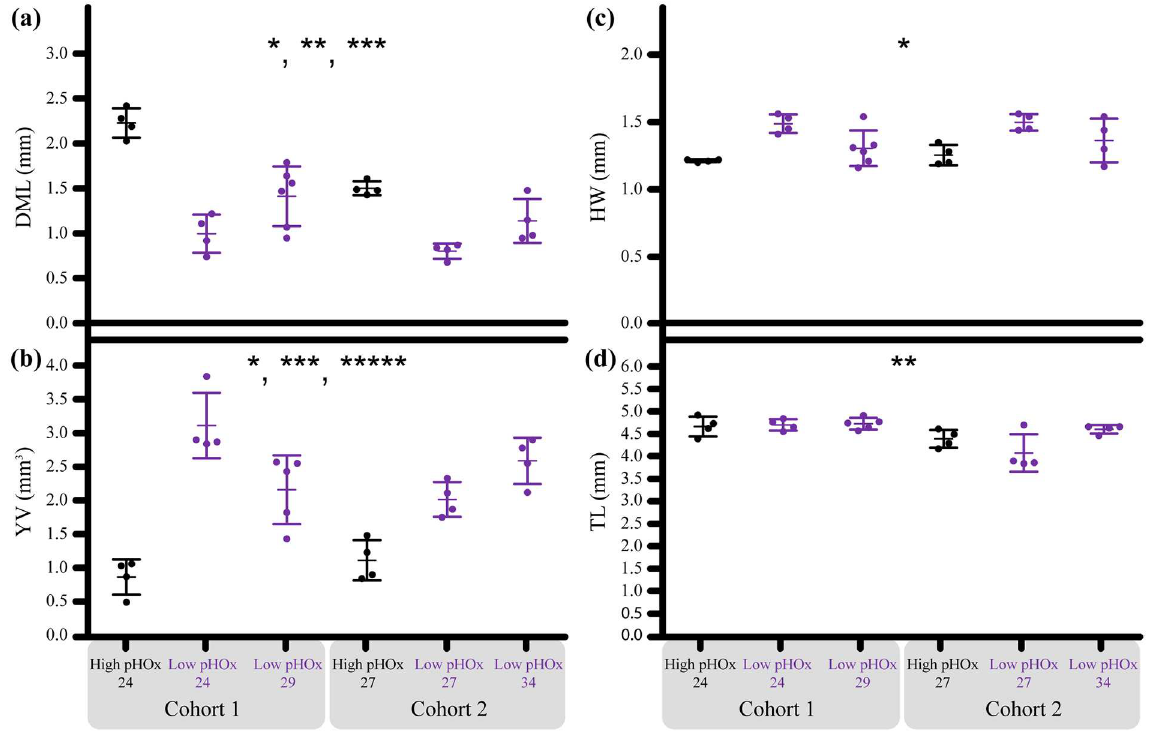
Fig 3. The embryonic response across treatmentsand exposure duration for Experiment 1. Each point representsthe averageembryo value per capsule(N = 10 embryos per capsule). X-axis = Numbers indicate the exposuredurationin days. Points are groupedby treatment * exposure * cohort. (a) DML = Dorsal mantle length (mm). (b) YV = Yolk volume (mm 3 ). (c) HW = Head width (mm). (d) TL = Total length (mm). * = treatment effect ( p < 0 . 001 ), ** = cohort effect ( p < 0 . 0001 ), *** = exposureduration effect ( p < 0 . 0125 ), ***** = capsuleeffect ( p < 0 . 01 ). There were no tank effects. Bars = ± 1 standarderror.